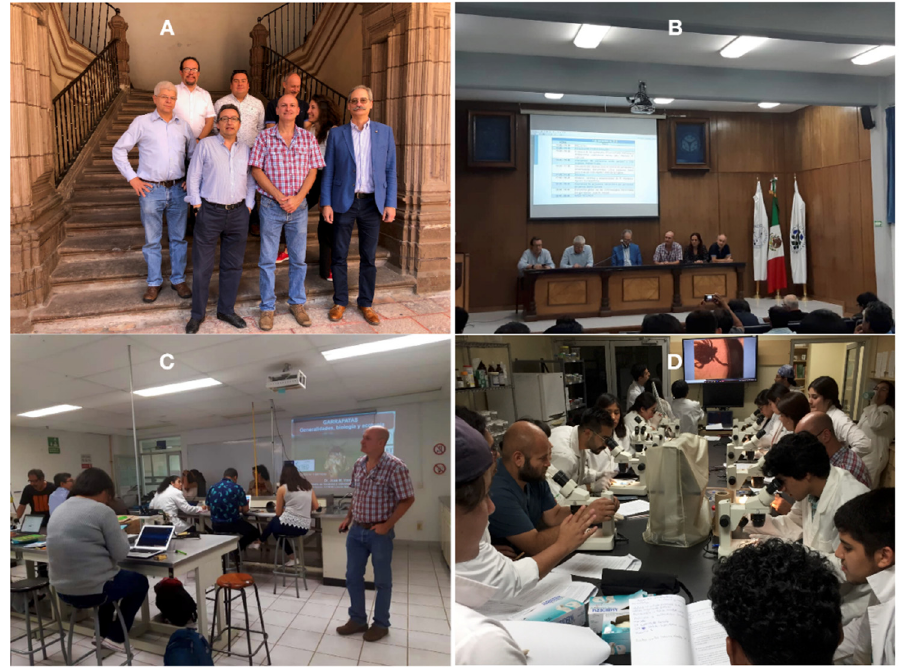
Figure 1. Some events in the meeting of the network “LaGar” in Querétaro, México. ( A ) The members of the network who attended the meeting. From left to right, top row, Juan Mosqueda, Octavio Merino, and Matias Szabó; mid row, Marcelo Labruna and Evelina Tarragona; bottom row, Agustín Estrada-Peña, José M. Venzal, and José de la Fuente. ( B ) The main session of lectures on tick ecology